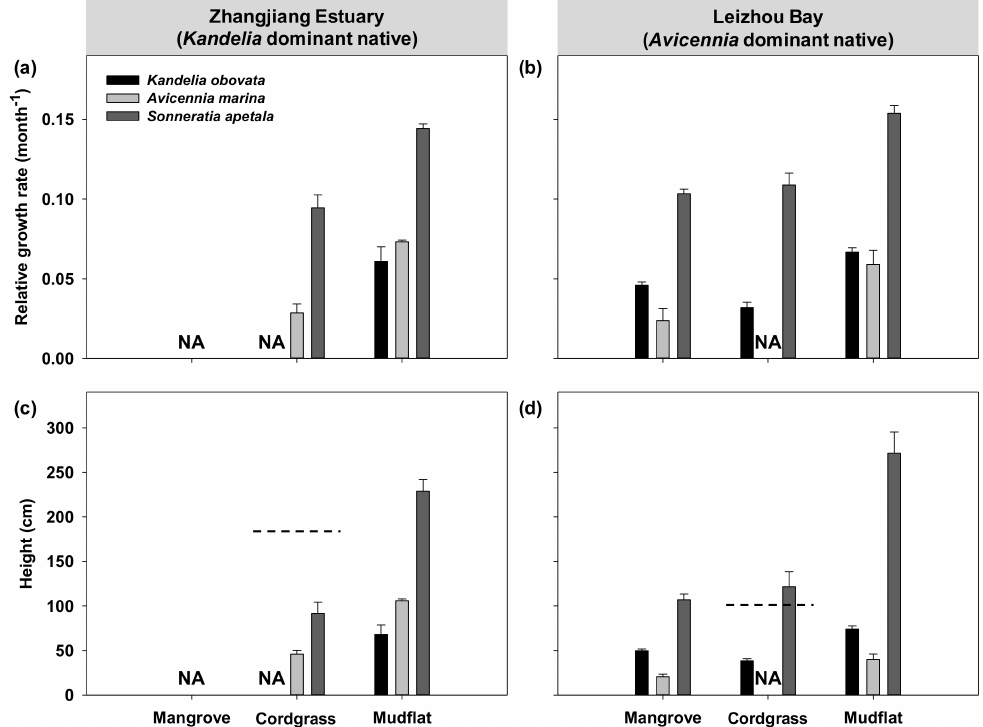
Figure 3. Relative growth rate ( a , b ) and height ( c , d ) of surviving seedlings at the end of two growing seasons in three habitats in Zhangjiang Estuary and Leizhou Bay. Data are means + SE ( n = 3~6 per treatment). NA = data not available because all the seedlings died. The dashed lines indicate the height of the Spartina alterniflora canopy at each site. Growth rates and height were different among species in each habitat at each site (Supplementary Tables S2 and S3) except for the mangrove habitat in Zhangjiang Estuary, where all seedlings